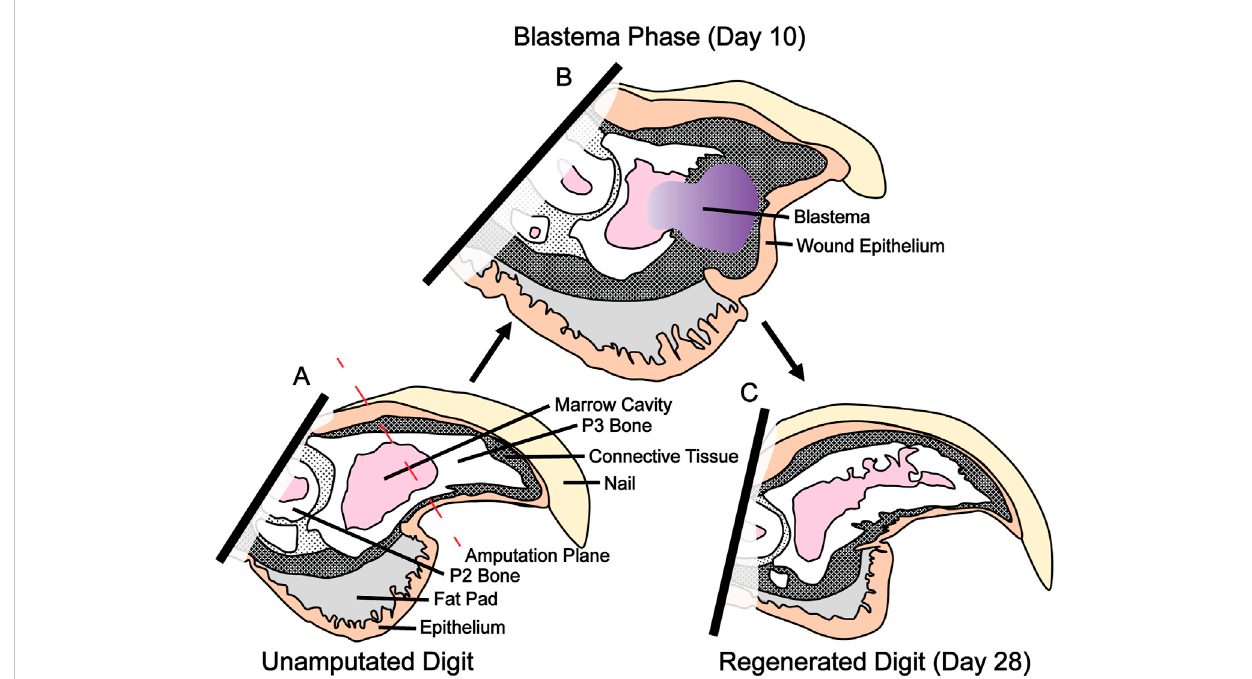
FIGURE 1 P3 amputation, blastema formation and regeneration. (A) Amputation through the third phalangeal element (P3) bisects the nail, epithelium, connective tissue, and P3 marrow cavity. (B) Blastema formation occurs betweenday 10 and 12. This heterogeneous fi broblast population will eventually become the regenerated bone and soft tissue. (C) Regeneration of bone and soft tissue is complete by day 28.